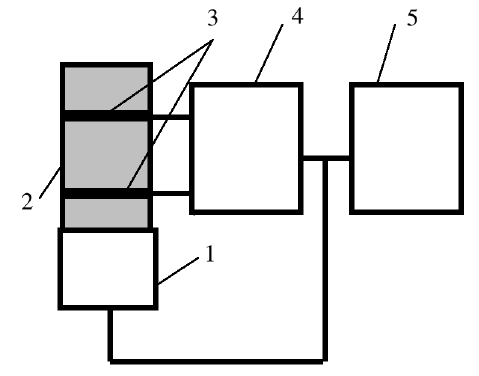
Fig. 1. The skeleton diagram of the laboratory device for the investigation of mechanoelectric phenomena in rocks: 1 – electric generator; 2 – piezoelectric transduc- er; 3 – sample; 4 – electrodes; 5 – amplifier; 6 – recorder.